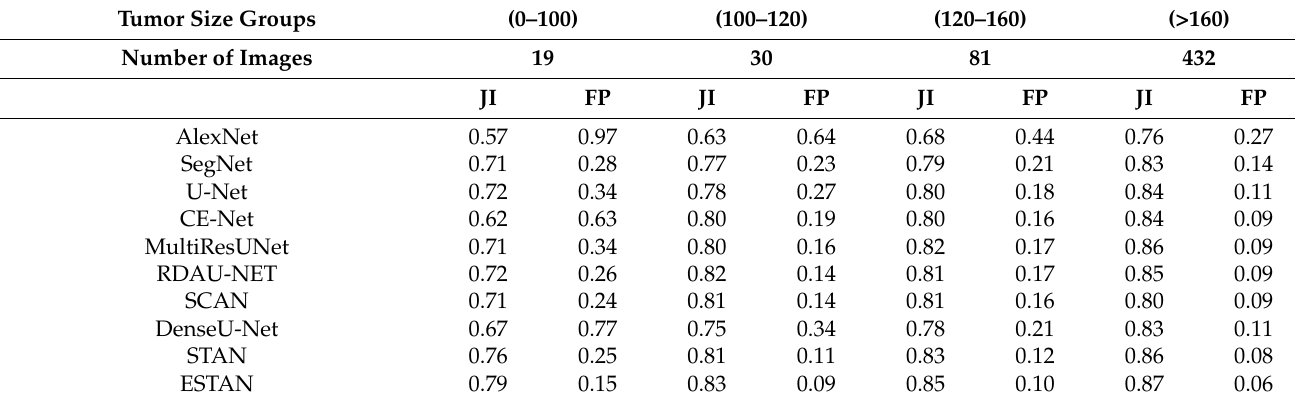
Table 4. Performance of four tumor size groups of BUSIS